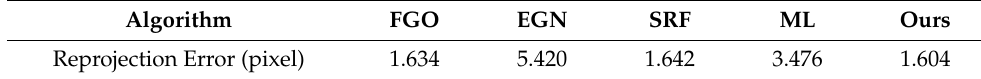
Table 1. The reprojection errors using the 3D box dataset.